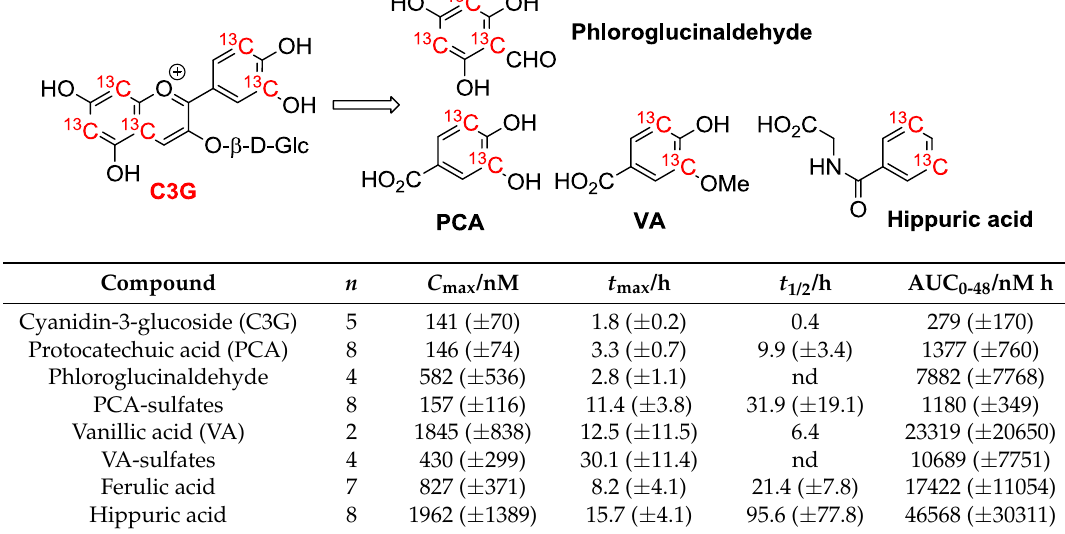
Table 2. Serum pharmacokinetic profiles of cyanidin 3-glucoside (C3G) and its metabolites in humans after the consumption of 500 mg 13 C-labelled C3G. From reference [3] (in red is the reference compound and its most abundant metabolites).